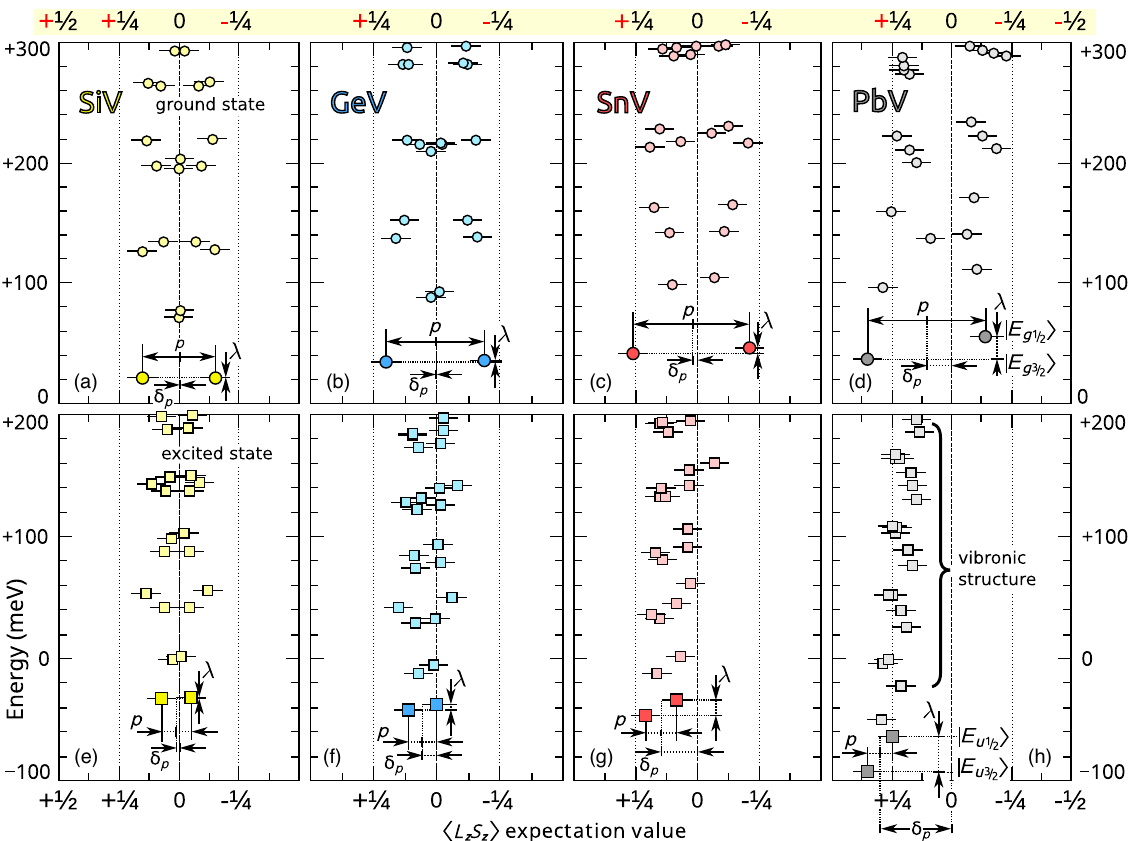
FIG. 5. Calculated eigenvalues of the adjoint DJT [Eq. (4)] and SOC [Eq. (2)] interaction for the X V ð − Þ color centers. The two lowest eigenvalues for each figure correspond to the 2 E vibronic g ground states (a – d) and the optically allowed u excited states g ; u (e – h). All of the considered eigenvalues are doubly degenerate in spin dimension because of the Kramers degeneracy. Each state consists of a pure ↑ or ↓ spin state; thus, the fourfold degeneracy of 2 E is fulfilled. We label the energy difference of the two g;u lowest-energy states by λ , which is directly observed in the fine structure of the ZPL in the PL spectrum known as zero-field i ; S splitting. Along the x axis, we depict the eigenvalues with respect to their partially quenched spin-orbit coupling strength h L z z thus, one can directly read out the p factors from this figure. Here, δ shows deviation of the Ham reduction factors on the E and p g;u 3 2 E states. The larger the δ , the less accurate the treatment of SOC as a perturbation over DJT. We note that a mirror symmetry at p g;u 1 2 x ¼ 0 shows up for the ground state of the SiV center in the entire vibronic spectrum, which demonstrates that SOC can be treated as a perturbation over the JT effect. The systematic left shift at the x axis for the vibronic spectrum of the SnVand PbV defects implies that SOC is comparable to the JT